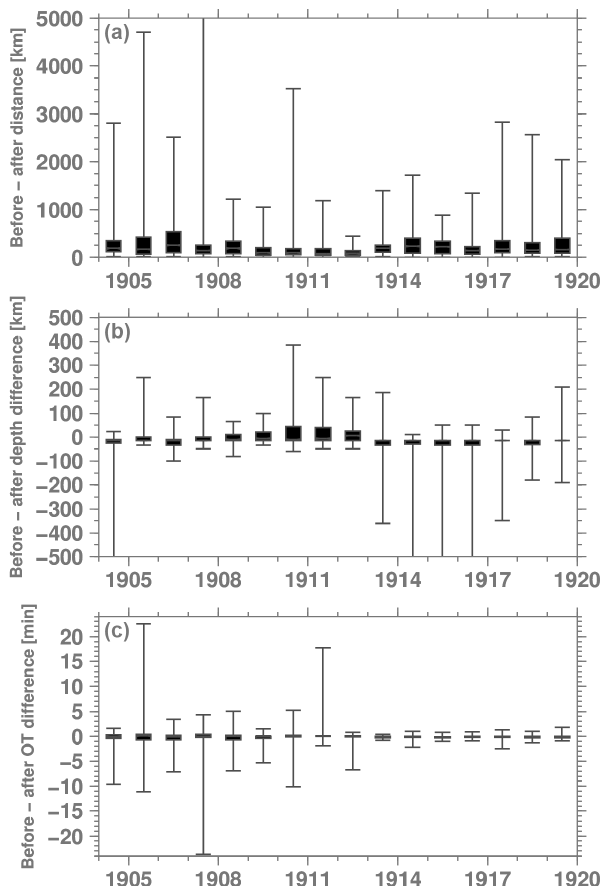
Figure 17. Box-and-whisker plots of the epicentre (a) , depth (b) and origin time (OT) differences between previous (before, see Fig. 12) and ISC-GEM hypocentres (after) in each year. For 880 of the 1110 extension events relocated between 1904 and 1919 the depth of the previous locations was unknown and nominally set to zero.